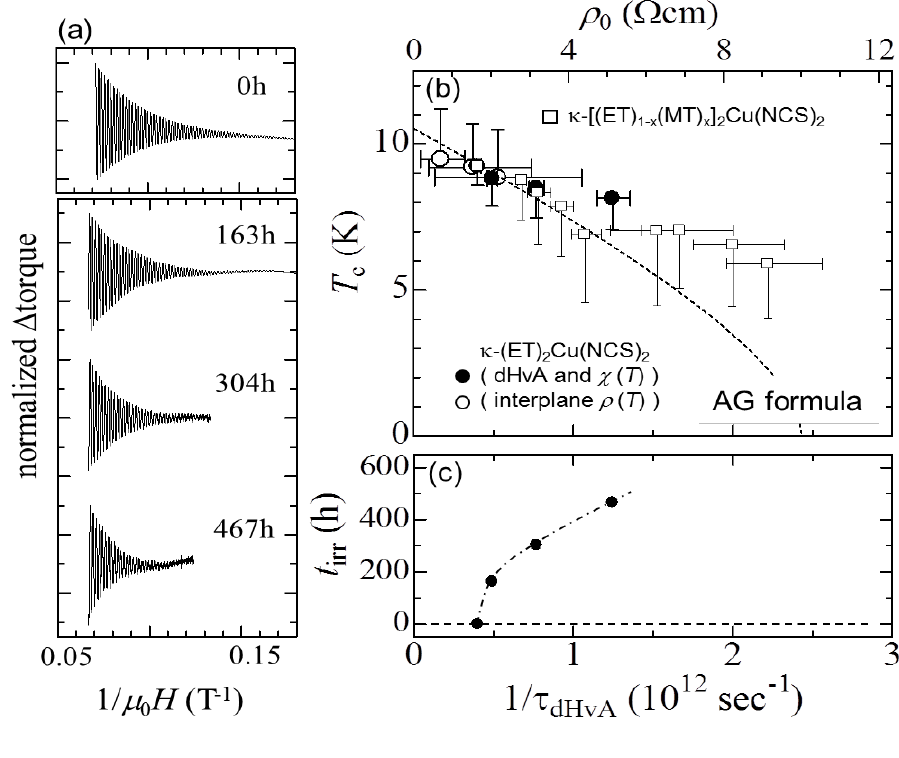
Figure 9. ( a ) de Haas–van Alphen oscillations of κ-(BEDT-TTF) Cu(NCS) at 0.44 K 2 2 before and after X-ray irradiation. The magnetic fields are applied perpendicularly to the conductive two-dimensional plane. The amplitude of the oscillations is normalized by the value of each oscillation at 14 T; ( b ) Relation between T and the inverse of the scattering c . In addition to the X-ray irradiated sample, the data of the partially BMDT- dHvA TTF (MT) molecule substituted sample is included for comparison. The dashed curve represents the Abrikosov-Gor’kov formula; and ( c ) The irradiation time dependence of the dHvA